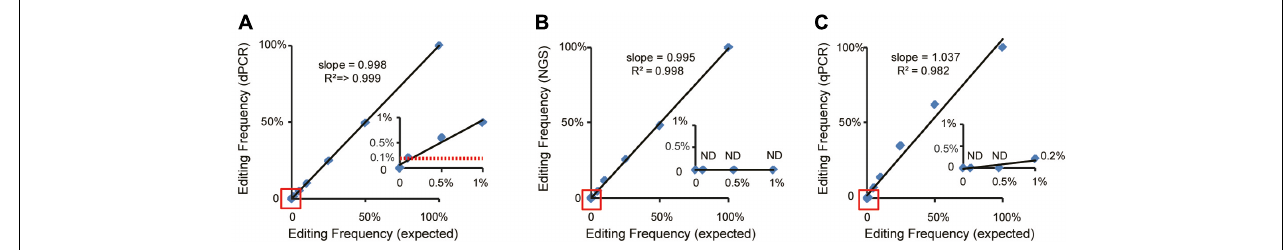
FIGURE 4 | Comparison and analysis of dPCR-, qPCR-, and NGS-based methods. Standard curves show the relationship between expected editing frequency and editing frequency, respectively, measured by (A) the dPCR assay, (B) the NGS-based method, and (C) the qPCR assay. The red lines in panel (A) show a good relationship between 0.1% expected editing frequency and which measured by the dPCR assay. ND indicated undetected. TABLE 3 | Detection of gene-editing frequency via the NGS-based method. Editing frequency